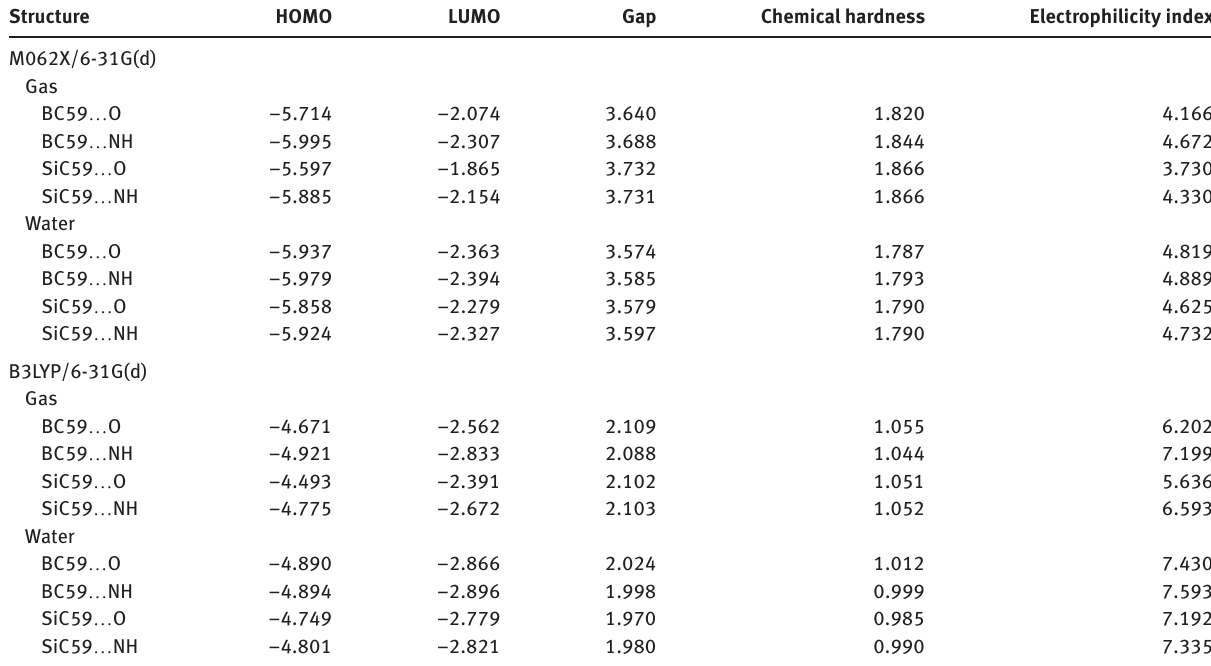
Table 2: Some energetic parameters (eV) of the investigated structures.